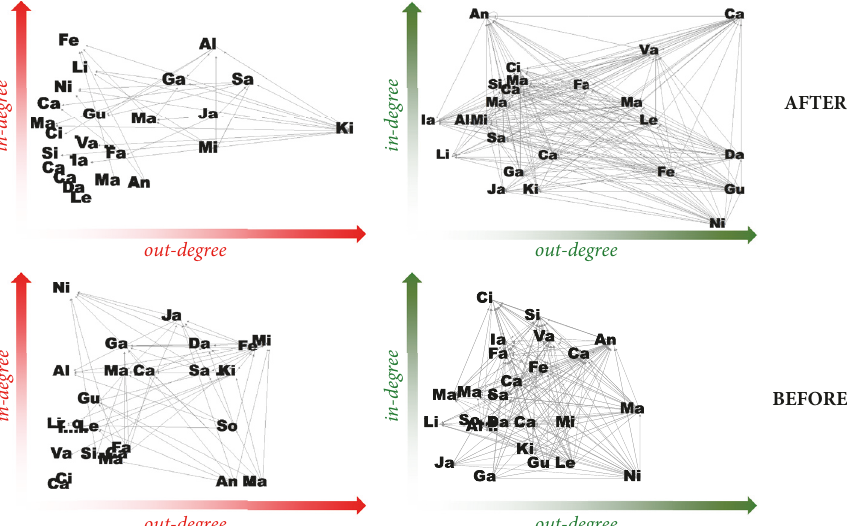
Figure 6: Experimental group networks. NNs (left) and PNs (right), before (bottom) and after (up) the intervention. Network layouts show those nodes with high number of in-degree connections located upper across the vertical axe and those with high number of out-degree connections located at the right of the horizontal